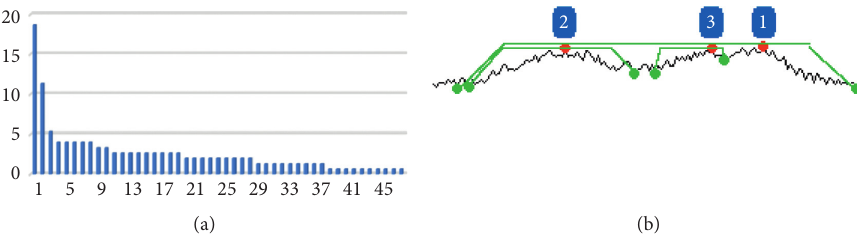
Figure 14: (a) Sorted prominences of Road6 data, where the ratio of the third (the prominence of the last detected peak) to the fourth (the greatest prominence of the noise) is 132%. (b) The detected peak points (each marked by its prominence ordinal number) and the supporting